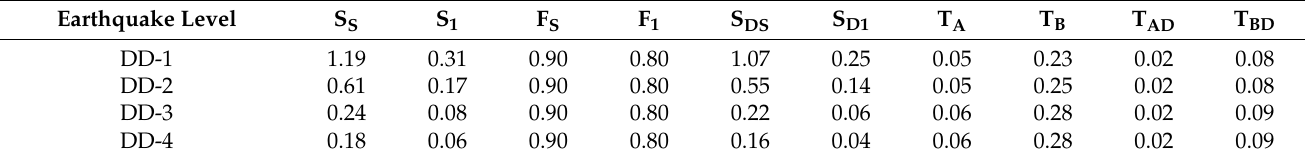
Table 6. Comparison of the seismic parameters for different earthquake ground motion levels.